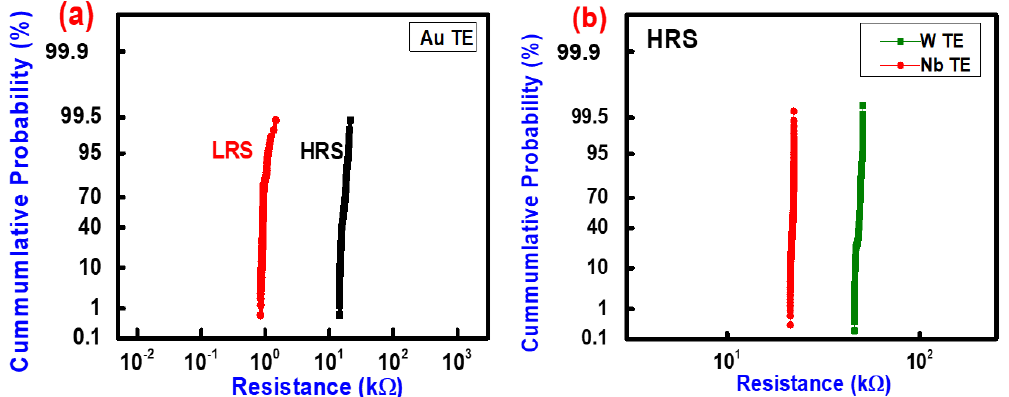
Figure 4. ( a ) The cumulative probability distribution of high resistance state (HRS) and low resistance state (LRS) of Au / NbO x / Pt device. ( b ) The cumulative probability distribution of HRS @ 0.20 V of switching Cycles of W / WO y / NbO x / Pt and Nb / NbO x / Pt devices.